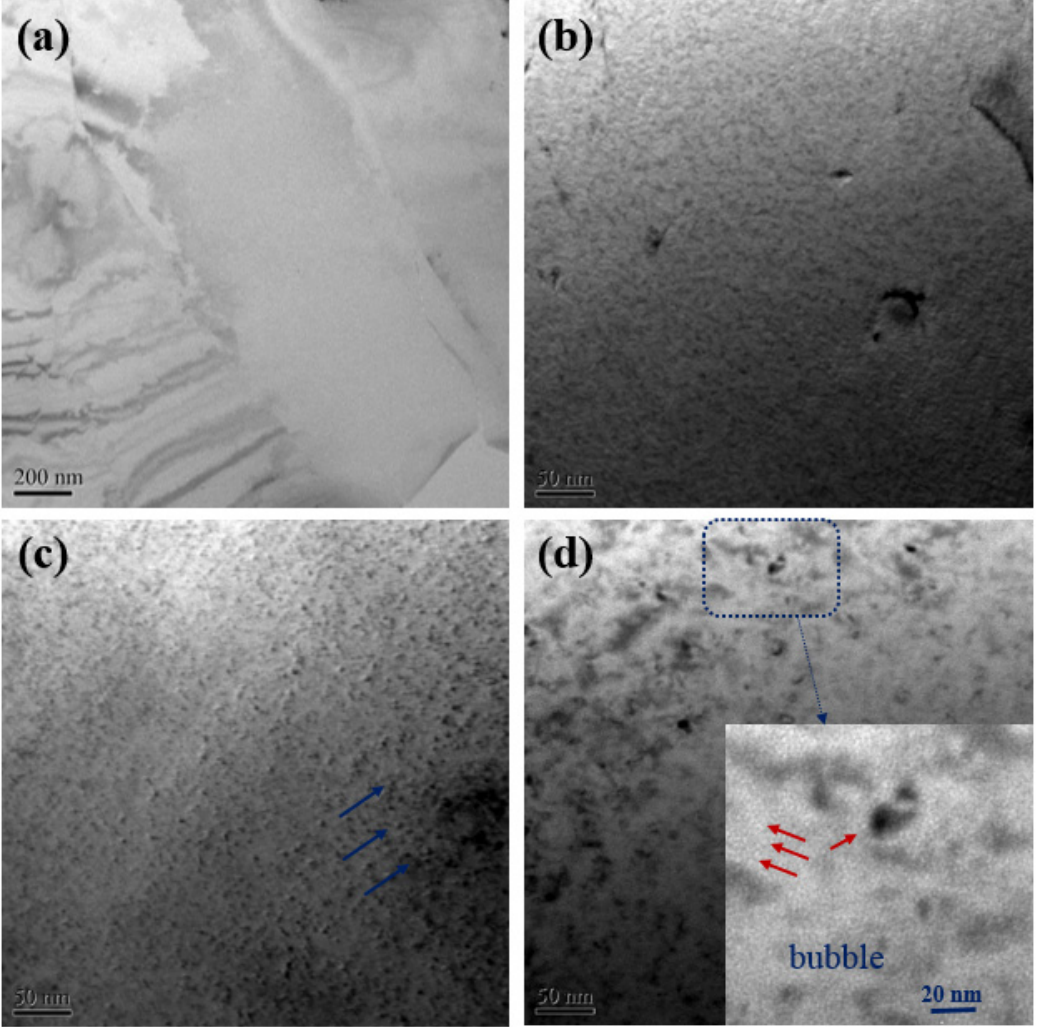
Figure 3. Microstructure changes of Fe9Cr alloy before and after helium irradiation at room temperature. ( a ) Unirradiated Fe9Cr, ( b ) 1 × 10 15 He + /cm 2 , ( c ) 1 × 10 16 He + /cm 2 and ( d ) 5 × 10 16 He + /cm 2 .